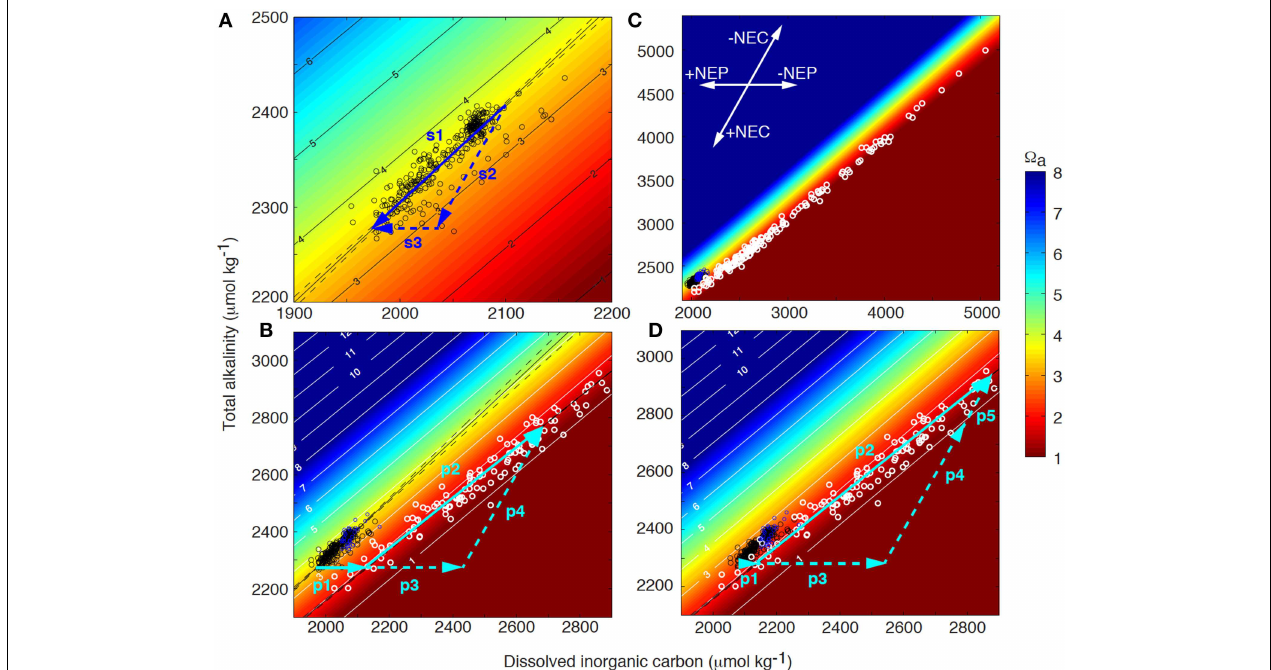
FIGURE 2 | Coral reef surface seawater (black circles) and pore water (white circles) total alkalinity (TA) as a function of dissolved inorganic carbon (DIC) superimposed on contours of aragonite saturation state ( (cid:127) a ) at 25 ◦ C and salinity of 36.5. (A) Net drawdown of surface seawater TA and DIC (vector s1) owing to net ecosystem organic carbon production (NEP, vector s3) and net ecosystem calcification (NEC, vector s2) as seawater transits the Bermuda coral reef platform (also see inset in panel C ). (B) Surface seawater acts as the starting composition for pore water. Initially, DIC increases and (cid:127) a decreases as a result of organic matter decomposition in the sediments (vector p1). The pore water (cid:127) a will decrease until it becomes undersaturated with respect to the most soluble bulk carbonate mineral phase present in the sediments, which will start to dissolve at a condition referred to as the